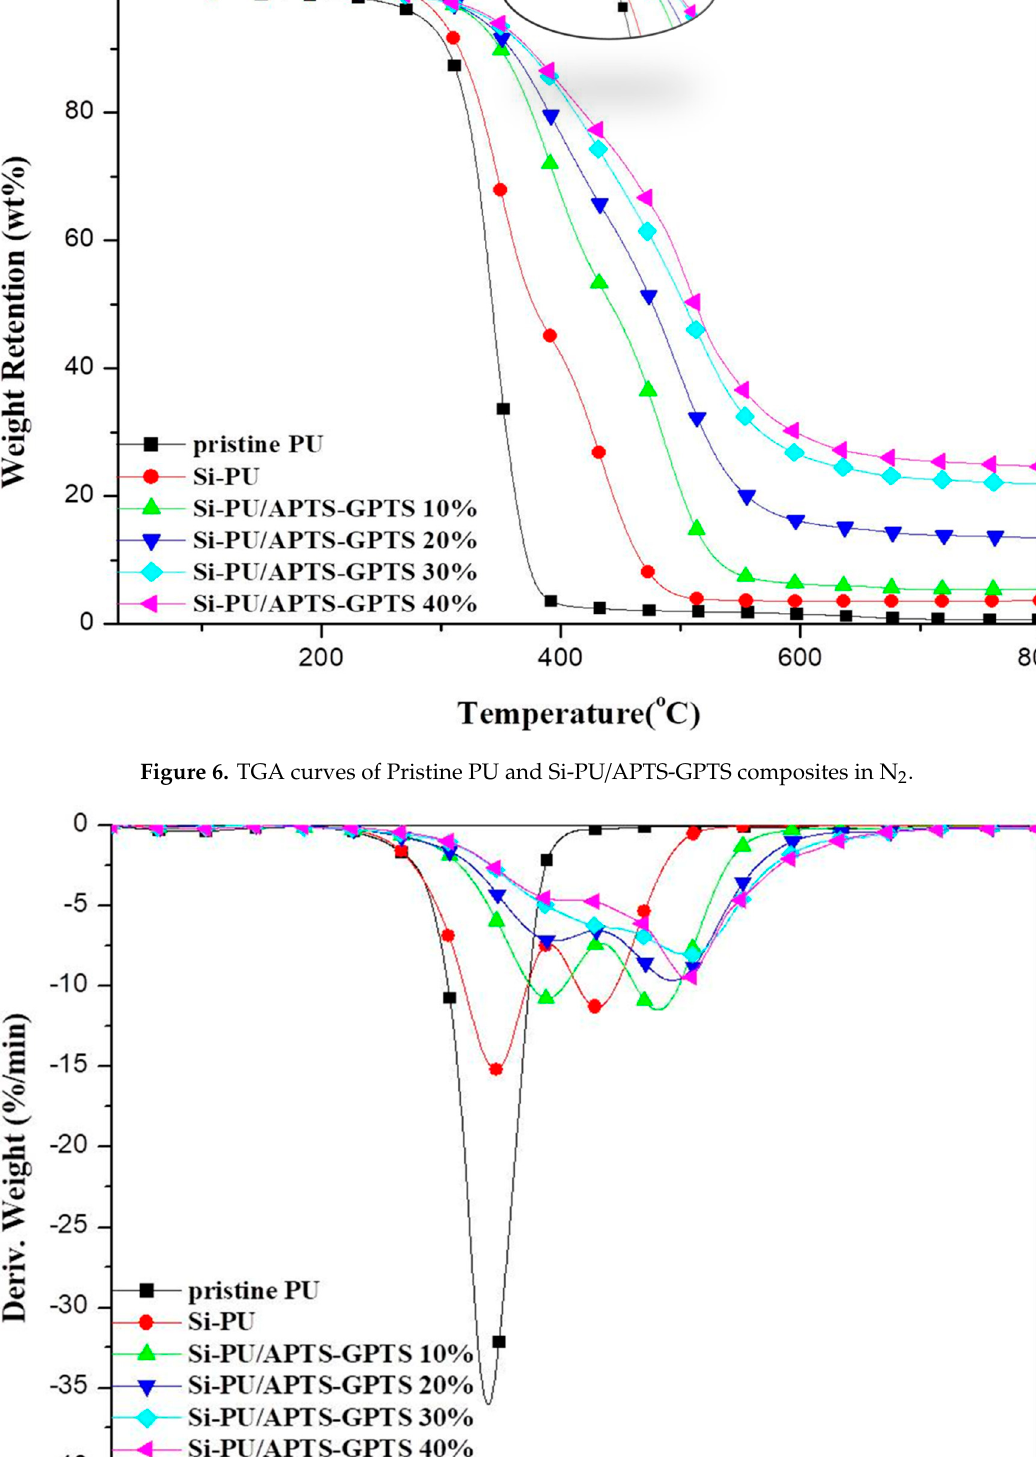
Figure 7. Derivative curves of pristine PU and Si-PU / APTS-GPTS composites in N 2